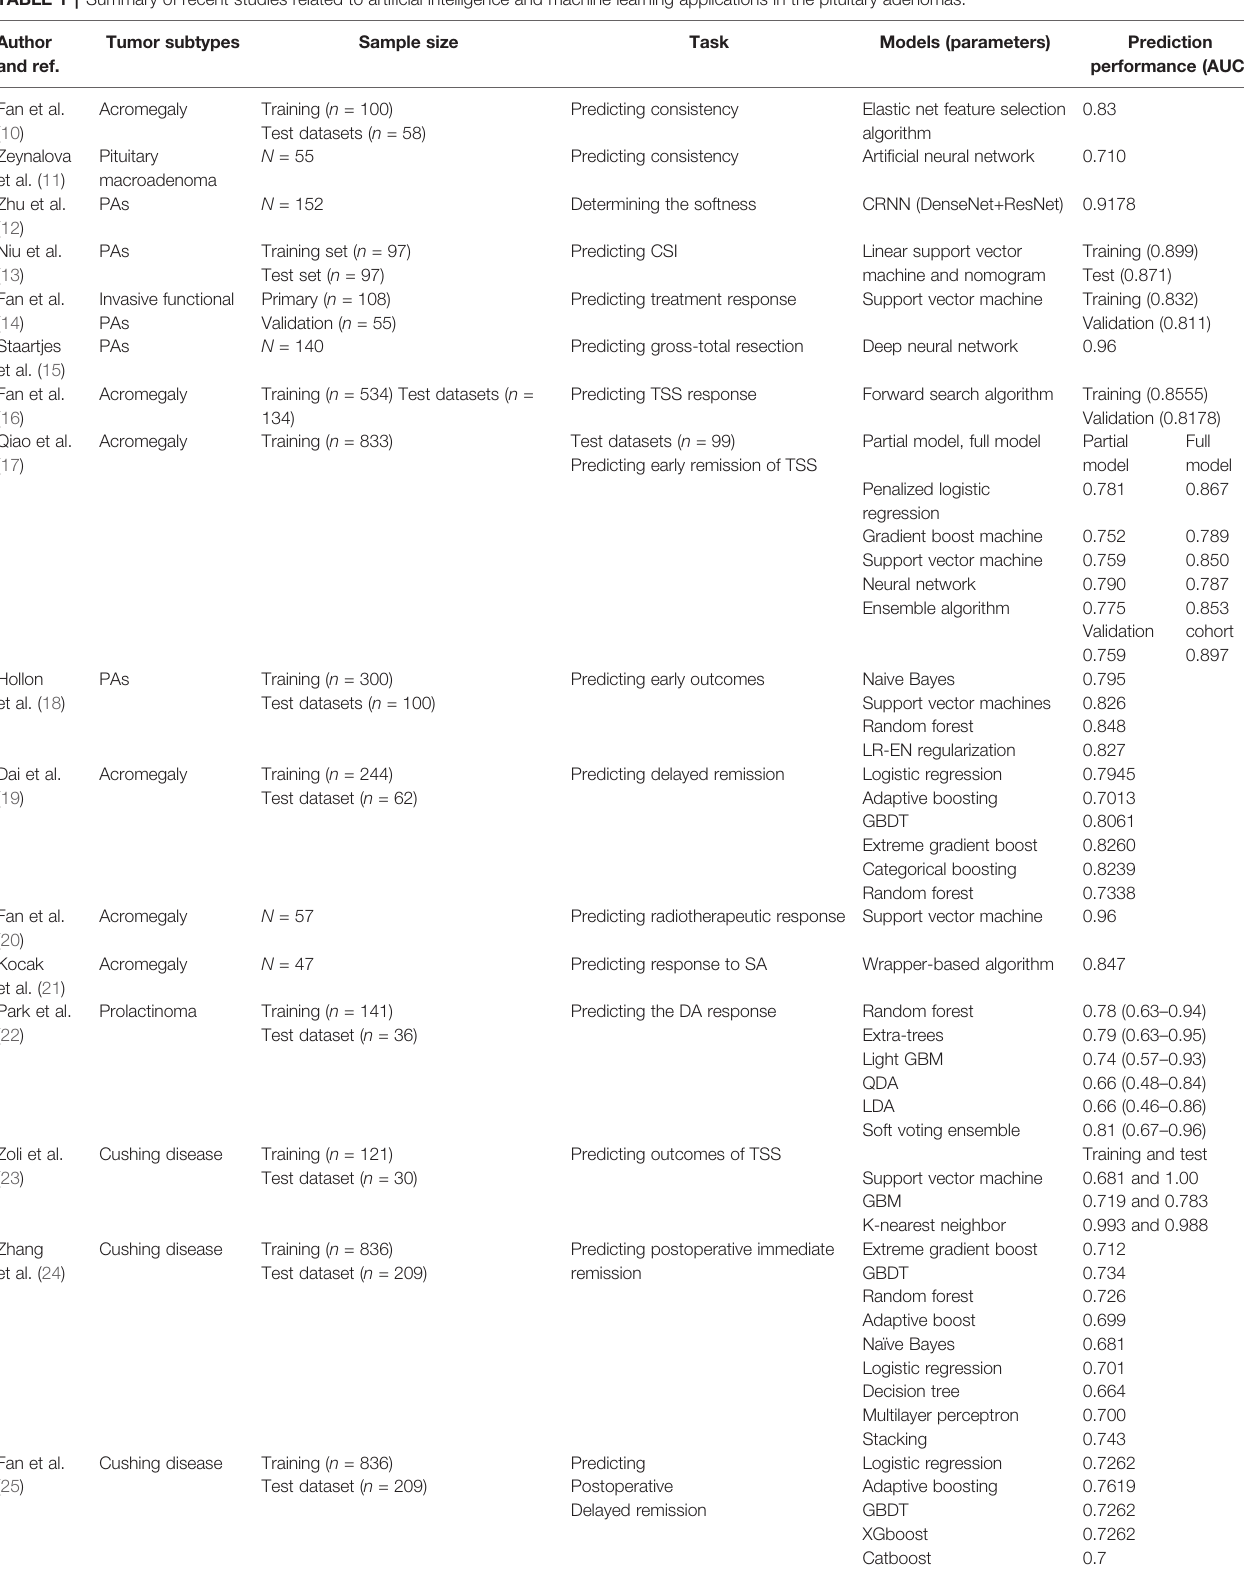
TABLE 1 | Summary of recent studies related to arti fi cial intelligence and machine learning applications in the pituitary adenomas. Author and